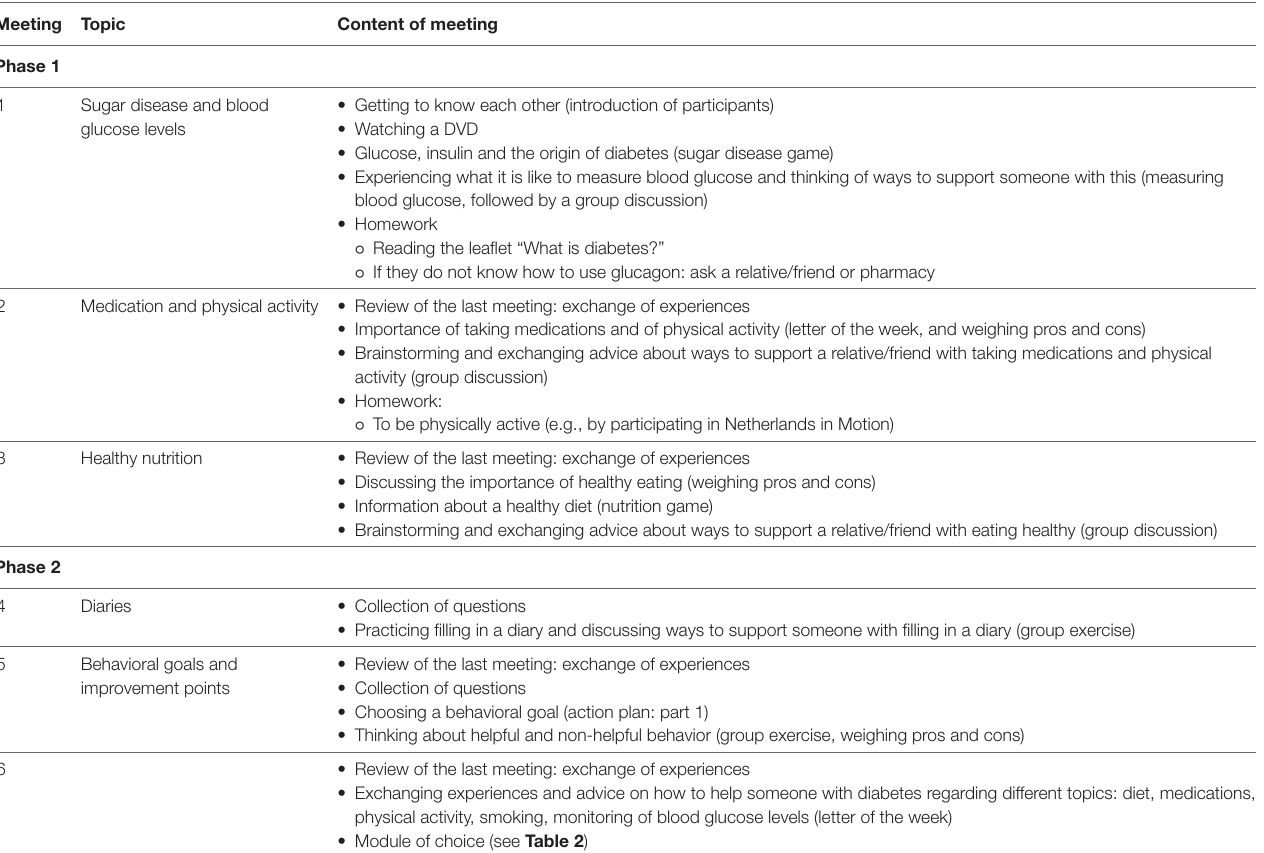
TaBle 6 | Overview of the content of the meetings for significant others. Meeting Topic content of